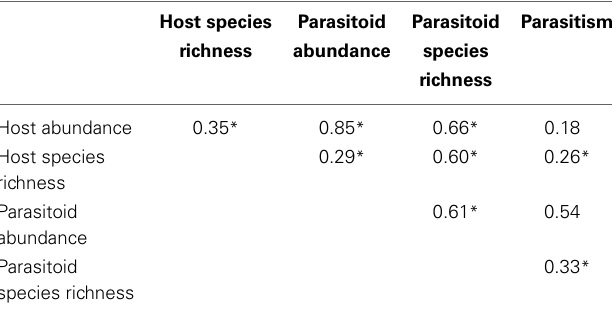
Table 2 | Pearson correlation coefficients between host and parasitoid species richness and abundance and parasitism.